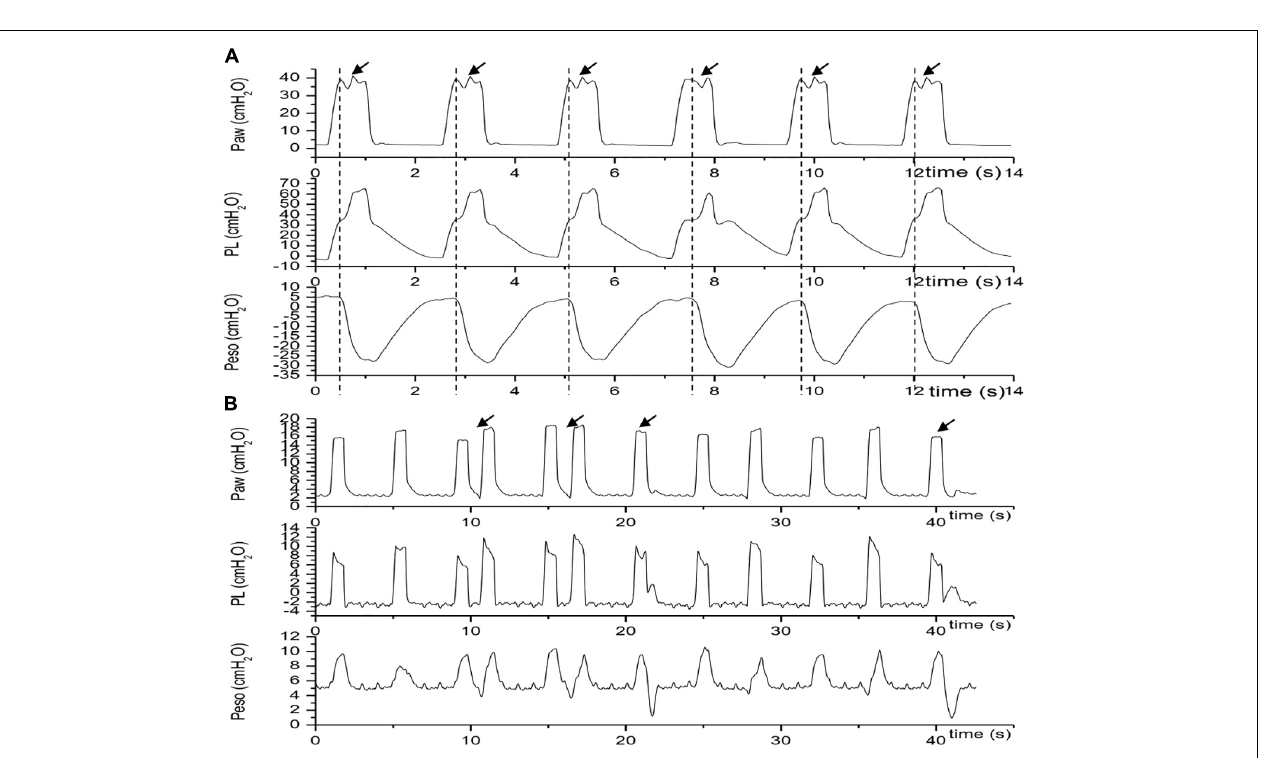
FIGURE 3 | Traces of Paw, PL and Pes during reverse trigger episodes. The vertical dashed line indicates an initiation of a patient effort which is express as the negative fluctuation of esophageal pressure, the arrow indicates a breath with reverse trigger. (A) Stable reverse trigger (1:1 entrainment) traces acquired in patient No.2; (B) unstable reverse trigger traces acquired in patient No.4. Paw, airway pressure; PL, transpulmonary pressure; Peso, esophageal pressure. TABLE 3B | Phase delay, Phase angle and the (cid:49) Peso during reverse trigger. Patient